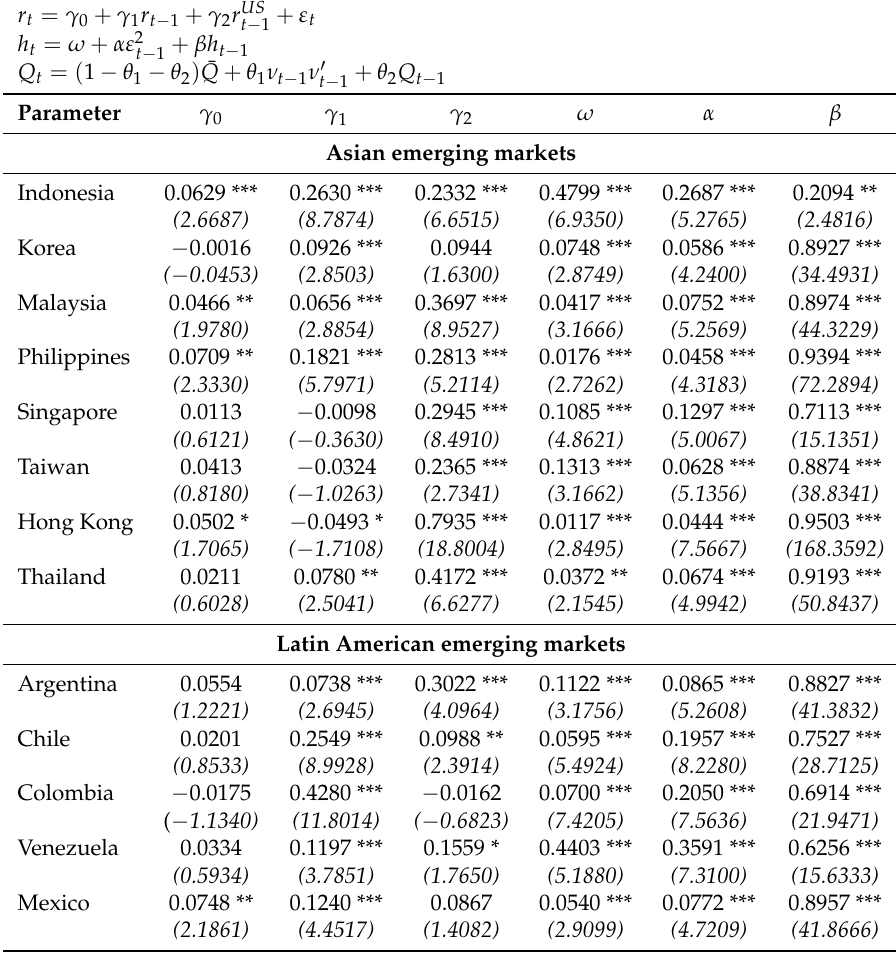
Table 5. Estimation of DCC-GARCH model for the Mexican “Tequila” crisis.